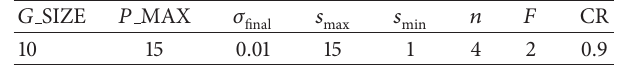
Table 2: Parameters values used by the